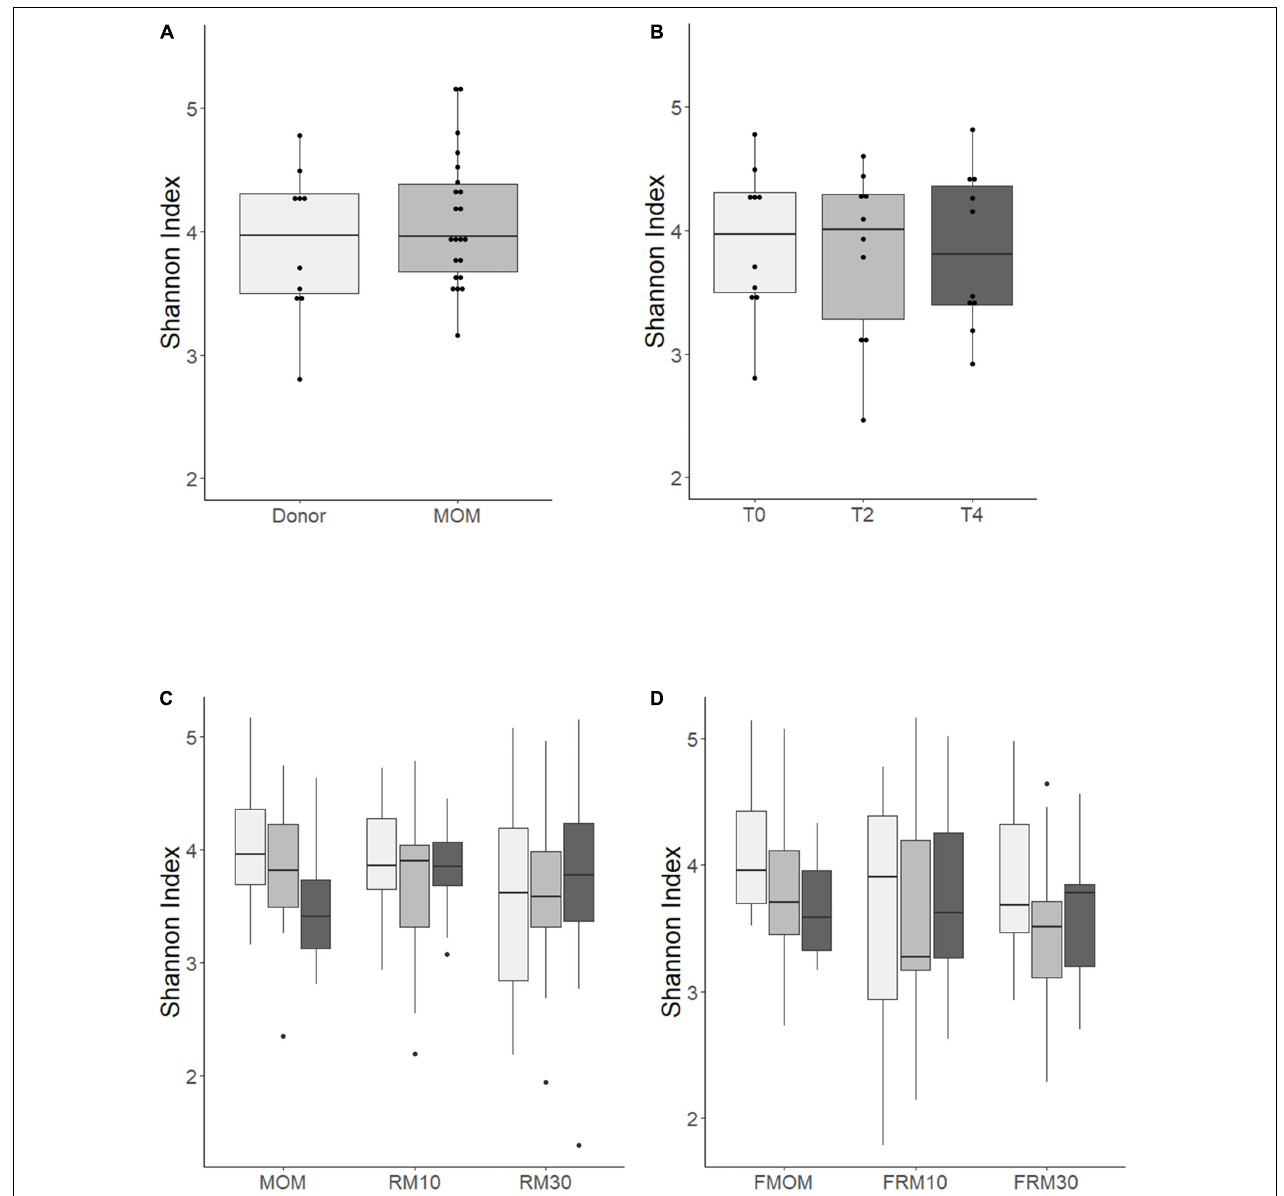
FIGURE 2 | Alpha diversity determination over time using Shannon index of: (A) MOM (gray box) versus DHM (light gray box) at T0; (B) DHM samples, (C) MOM and RM samples, (D) FMOM and FRM samples at time 0 (T0, light gray boxes) and incubated over 2 h (T2, gray boxes) and 4 h (T4, black boxes) at 37 ◦ C. Statistical significance was determined using ANOVA followed by Kruskal–Wallis